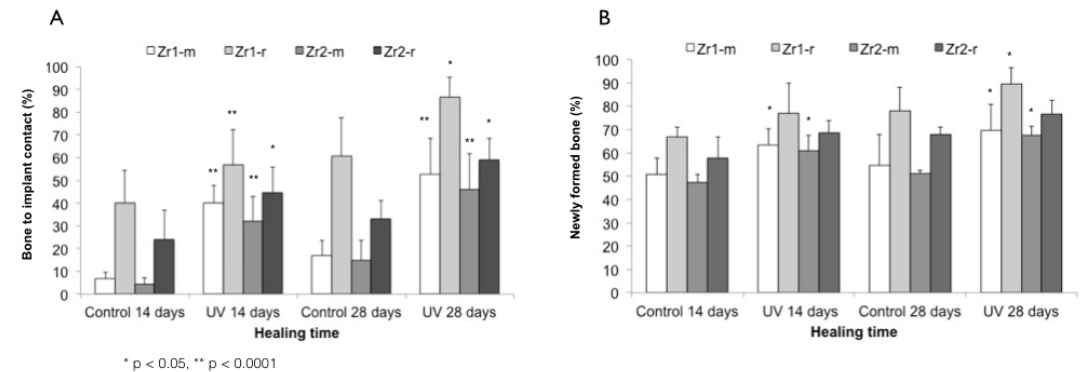
Figure 10. Histomorphometry values of bone-implant contact ( A ); bone volume ( B ) around Zr1-m, Zr1-r, Zr2-m and Zr2-r before and after UV treatment.